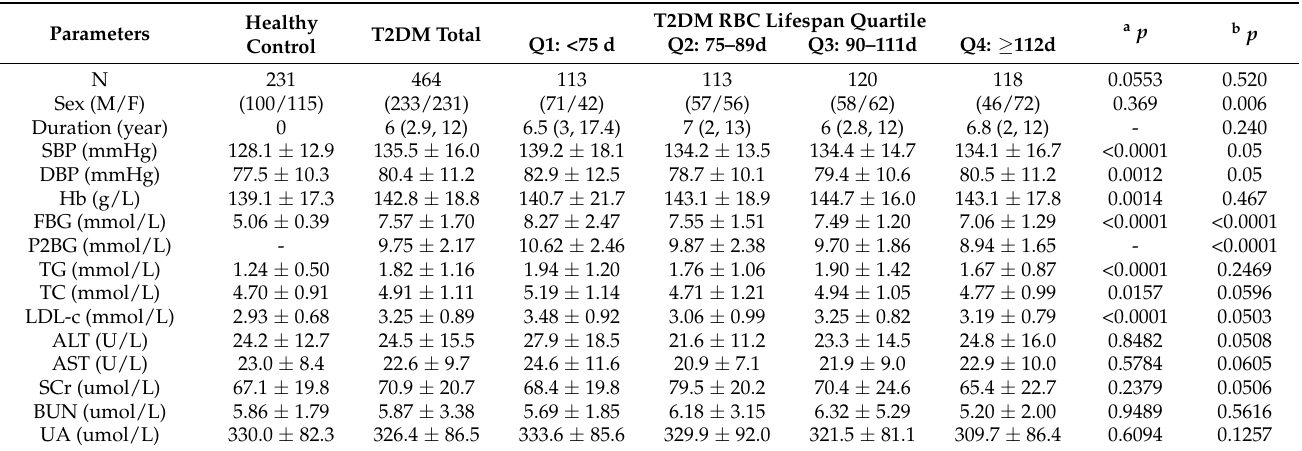
Table 1. The clinical characteristics of healthy control and T2DM